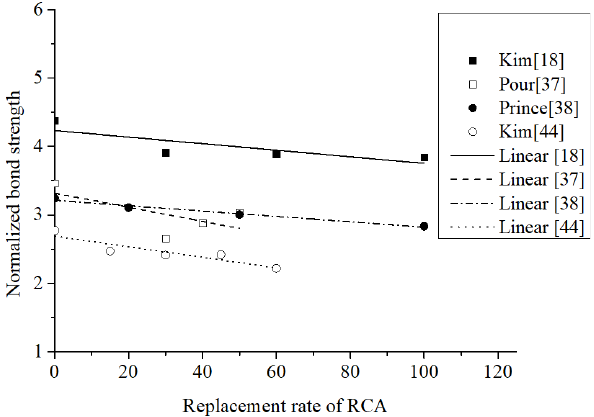
Figure 5: Normalized bond strength versus replacement rate of RCA